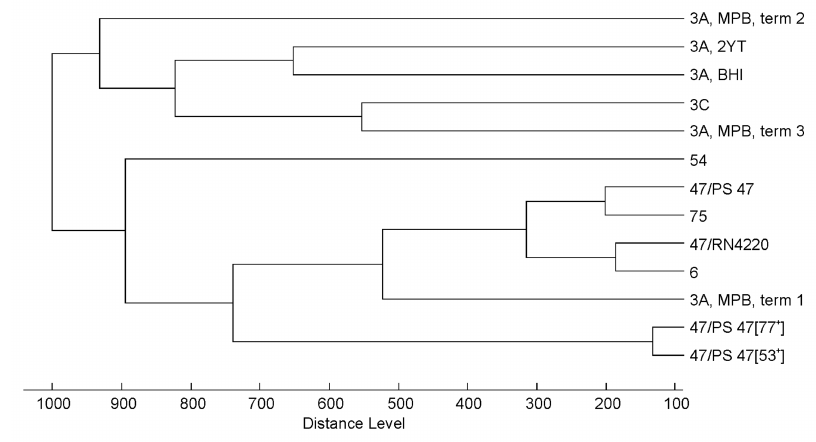
Figure 4. Cluster analysis of Triavirus mass spectra demonstrating the influence of the mass spectral variability of the method itself (phage 3A, term 1, term 2, term 3), variability resulting from different propagation strains (phage 47 propagated on S. aureus RN4220, PS 47, PS 47 [53 + ] and PS 47 [77 + ]) and different cultivation media (phage 3A propagated in meat-peptone broth (MPB), brain heart infusion (BHI) and 2 × yeast-tryptone broth